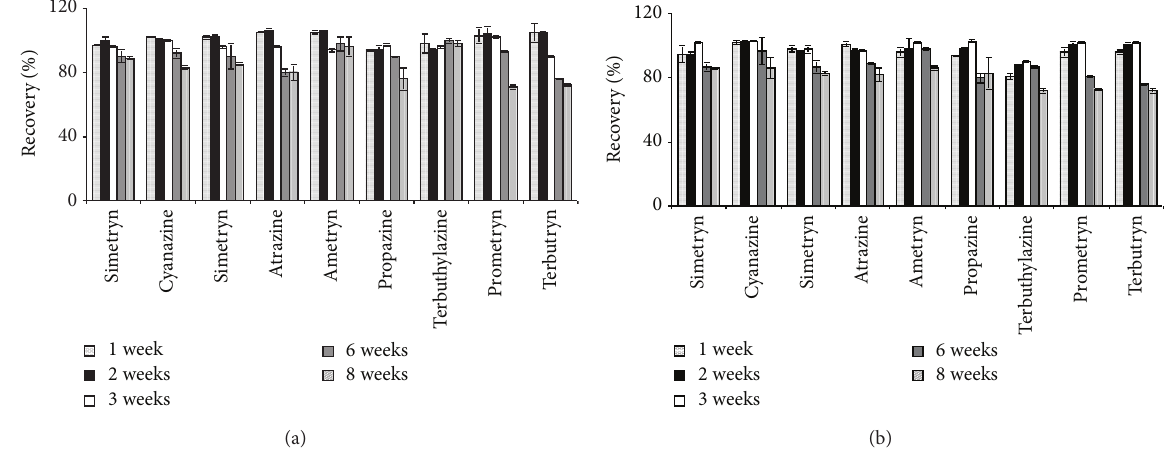
Figure 2: Effect of storage conditions on the recovery of the herbicides. (a) Temperature − 18 ∘ C, (b) temperature 4 ∘